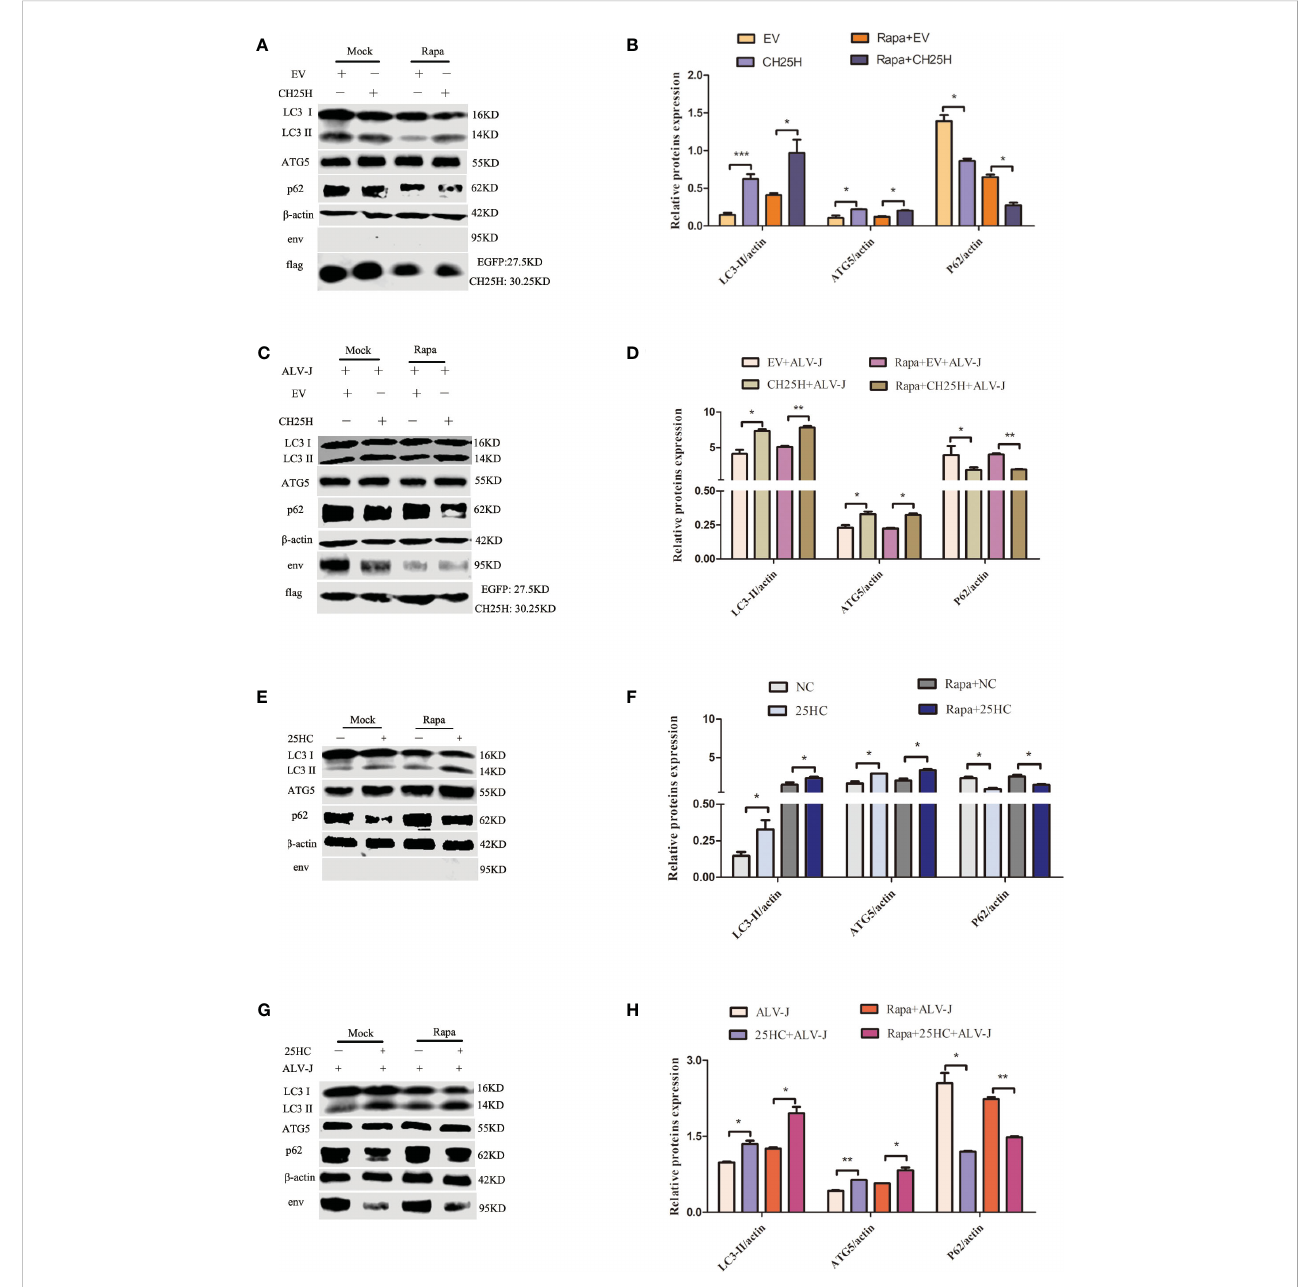
FIGURE 3 Both the overexpression of CH25H and the treatment with 25HC promote autophagy. (A) DF-1 cells were pretreated with 1 m M Rapa for 2 h and then were transfected with p fl ag-CH25H or p fl ag-EGFP for 48 h. Expression levels of LC3II, ATG5, p62, ALV-J env, fl ag-tagged CH25H, and fl ag-tagged EGFP were analyzed by immunoblot. (B) Quanti fi cation of LC3II/ b -actin, ATG5/ b -actin, and p62/ b -actin were analyzed by Image Studio software. (C) DF-1 cells that were pretreated with 1 m M Rapa for 2 h were transfected with p fl ag-CH25H or p fl ag-EGFP for 24 h, prior to being infected with ALV-J (10 5 TCID 50 / 0.1mL). The expression levels of LC3II, ATG5, p62, ALV-J env, fl ag-tagged CH25H, and fl ag-tagged EGFP were analyzed by immunoblot. (D) Image Studio software was used to quantify LC3II/ b -actin, ATG5/ b -actin, and p62/ b -actin. (E) DF-1 cells were pretreated with 1 m M 25HC for 12 h and replaced with fresh medium for 48 h, and the expression levels of LC3II, ATG5, p62, and ALV-J env were assessed by immunoblot. (F) Quanti fi cation of LC3II/ b - actin, ATG5/ b -actin, and p62/ b -actin were analyzed by Image Studio software. (G) DF-1 cells were pretreated with 25HC at a concentration of 1 m M for 12 h, followed by infection with ALV-J (10 5 TCID 50 /0.1mL) for 48 h. The expression levels of LC3II, ATG5, p62, and ALV-J env were assessed by immunoblot. (H) Image Studio software was used to quantify LC3II/ b -actin, ATG5/ b -actin, and p62/ b -actin by Image Studio software. Data shown are the means ± SEM of at least two independent experiments. P values were calculated using unpaired Student ’ t -test. A P values < 0.05 were considered statistically signi fi cant differences, and a P < 0.01 were considered highly statistically signi fi cant differences. * P < 0.05, ** P < 0.01, *** P <